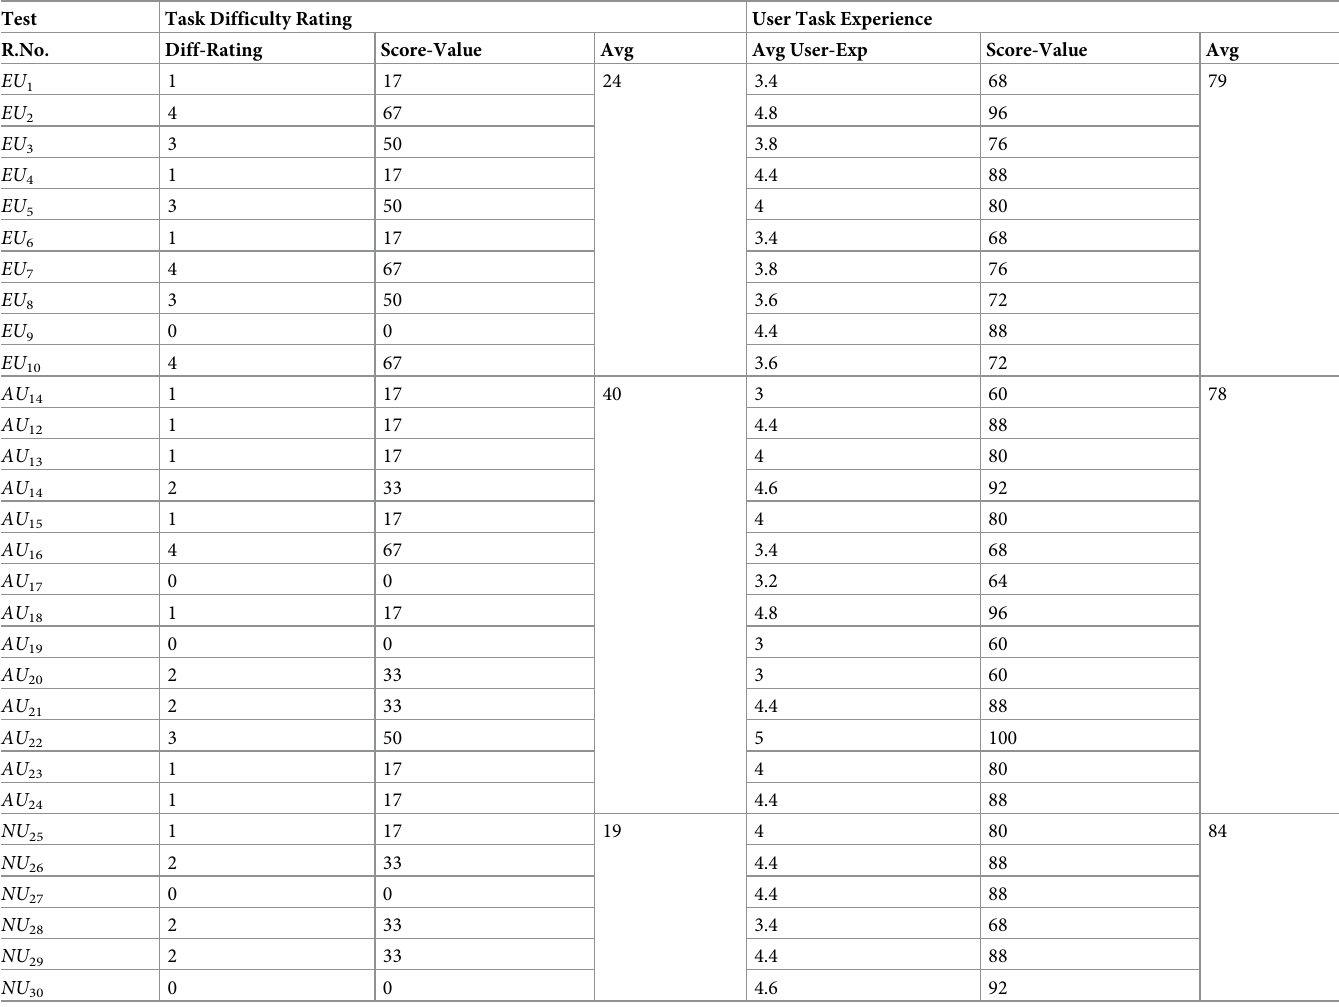
Table 1. Respondents task-difficulty-ratings & user-experience